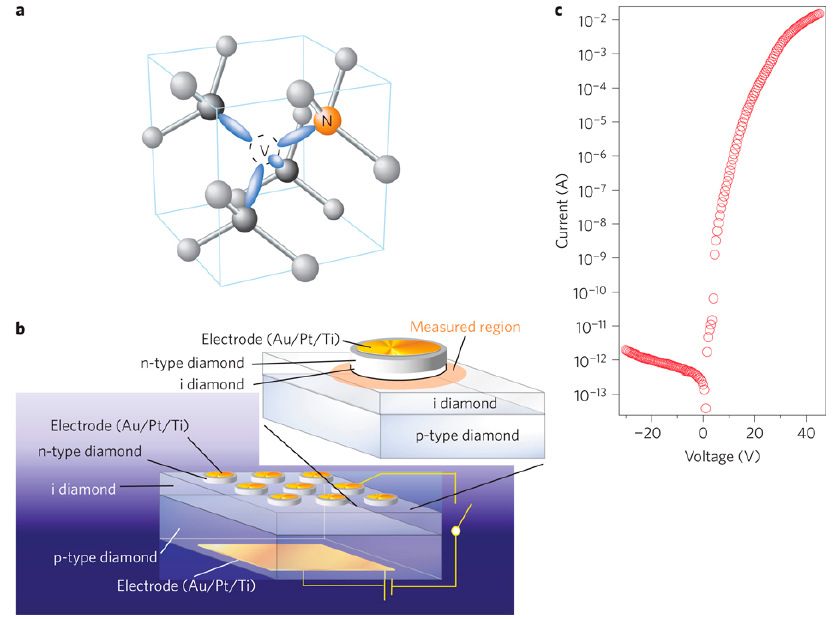
Figure 1. ( a ) Atomic structure of an NV center in diamond; ( b ) Schematic of the single photon emitting diode; ( c ) Current vs. voltage properties of the p–i–n junction in a log plot. Reprinted by permission from Reference [9], copyright 2012, Macmillan Publishers Ltd.: Nature Photonics.